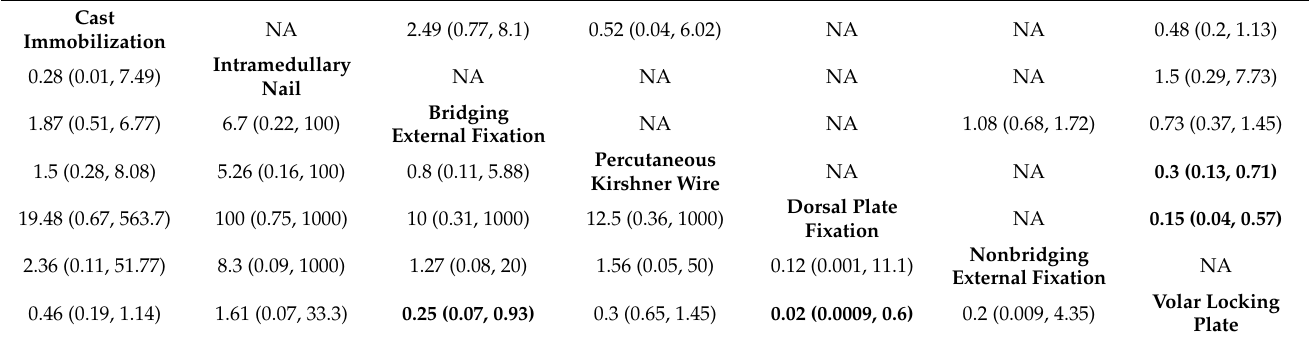
Table 5. Absolute and relative RR estimates (95% CI) on minor complications (*). Upper right triangle gives the mean difference from pairwise comparisons (column intervention relative to row) and lower left triangle gives the mean difference from the network meta-analysis (row intervention relative to